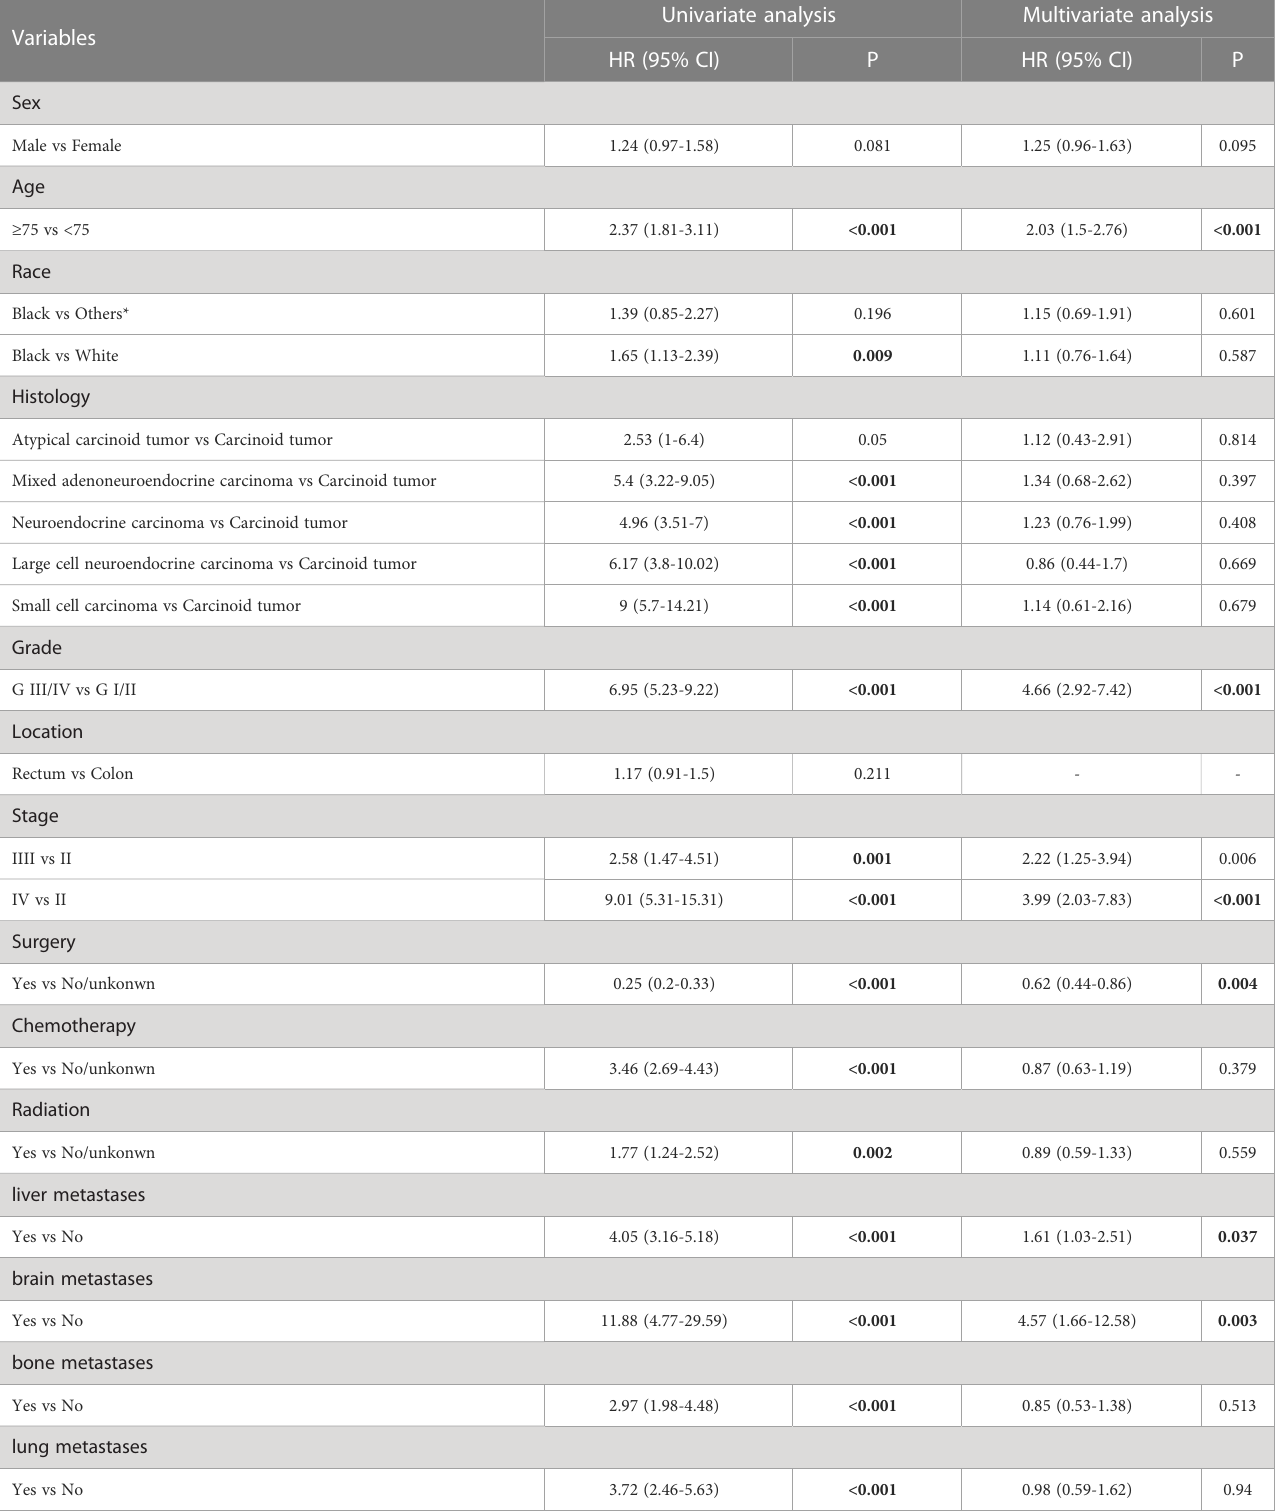
TABLE 2 Univariate and multivariate Cox analysis of OS of the II-IV stage patients with CRNENs.